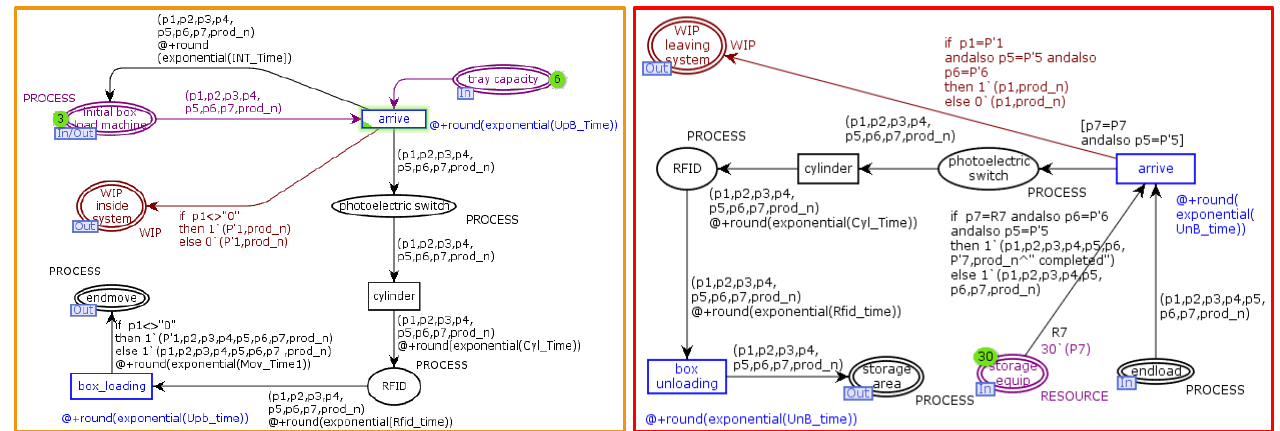
Figure 5. A snapshot of scenario “CPPM production-line” modelled on CPN tools.